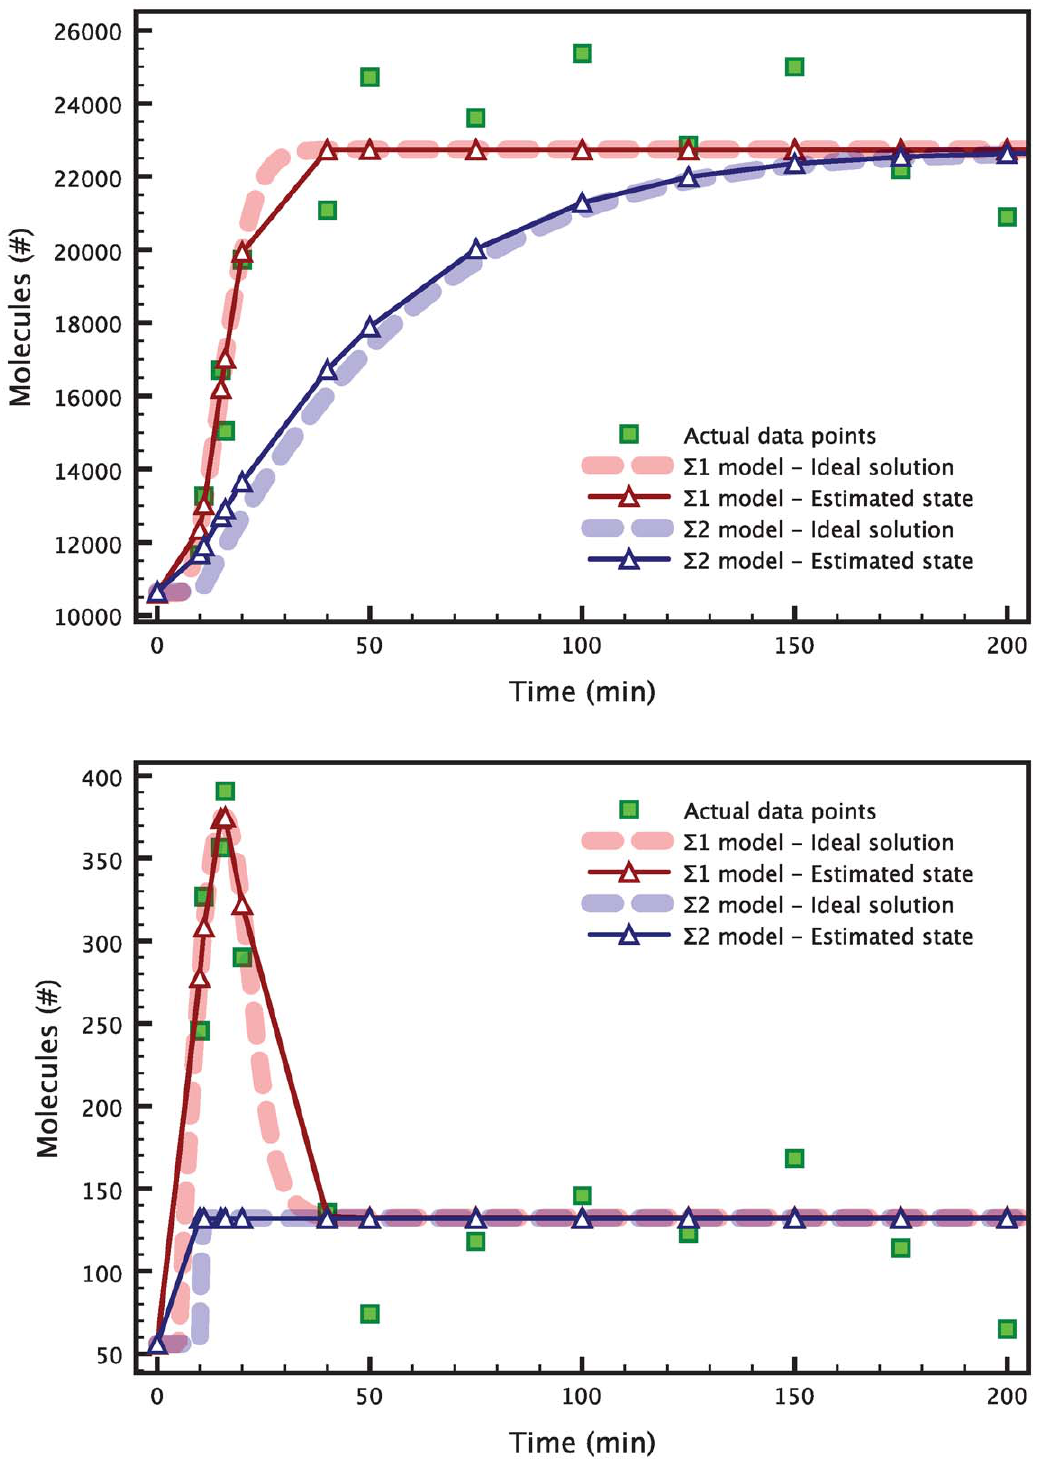
Figure 4. Discrimination between competing heat shock models. The models (18) (blue) and (19) (red) are compared in terms of their D t (top) and S t (bottom) outputs. Both signals evolve to the same steady state, but with different transient behavior. The dashed lines represent the ideal model solutions, the triangles are the corresponding Kalman filter estimates.